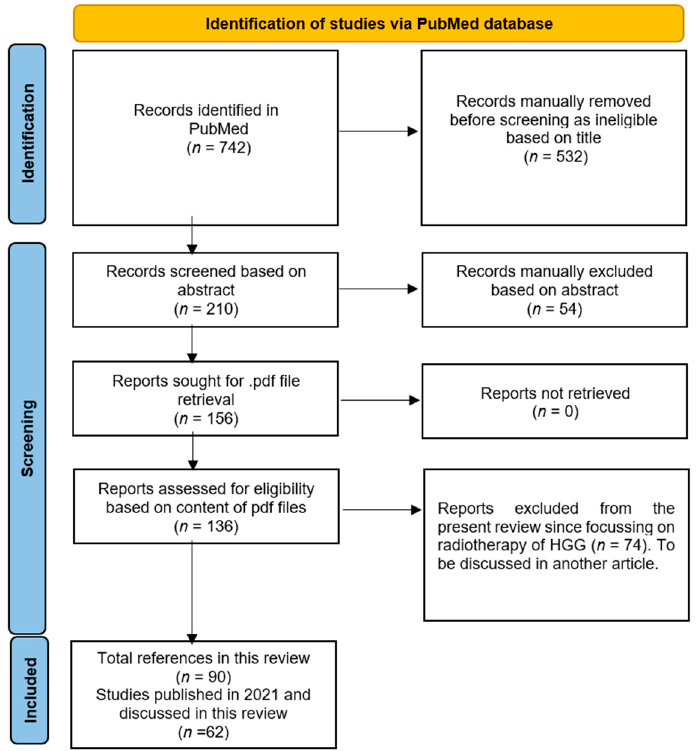
Figure 1. Flow diagram for reported studies (modi fi ed from [7] with